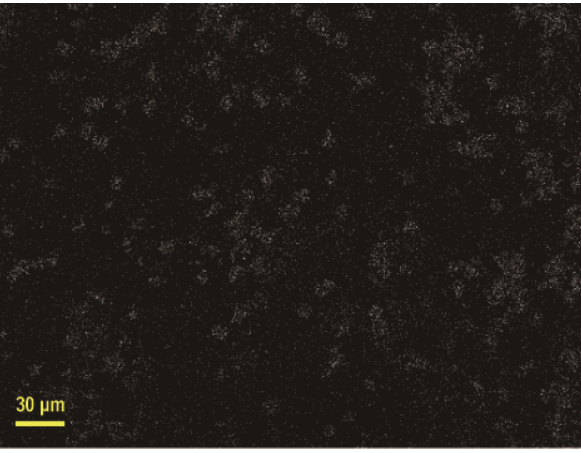
Figure 3. EDS surface scan images. Table 1. Content of each element in EDS face scan.